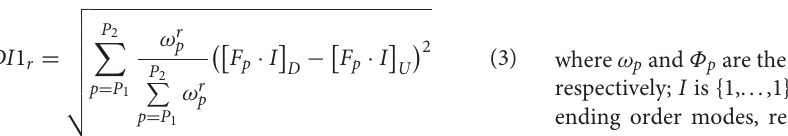
k is the number of the selected node; and r is the weight